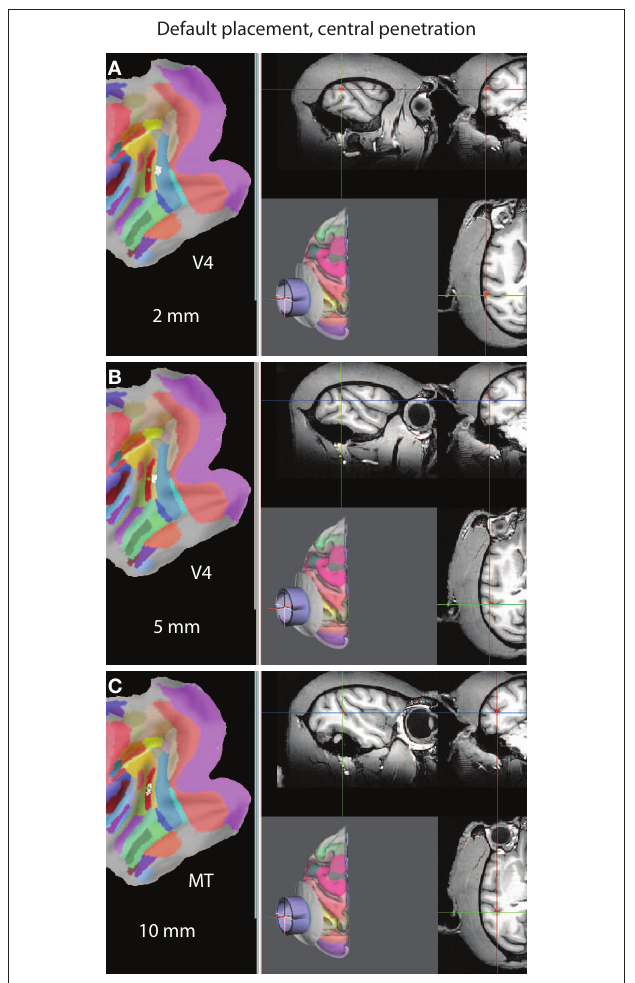
Figure 9 | A virtual electrode trajectory along the symmetry axis of the default placement. (A) Hitting V4 at a depth of 2 mm. White nodes on the flat map as well as red nodes on the MRI indicate locations surrounding the virtual electrode tip. The MRI slices intersect at the location of the electrode tip, also marked by the cross-hair cursors. (B) Hitting a different part of V4 at a depth of 5 mm. (C) Hitting MT at a depth of 10 mm. Note that the MRI slices are being updated as the virtual electrode